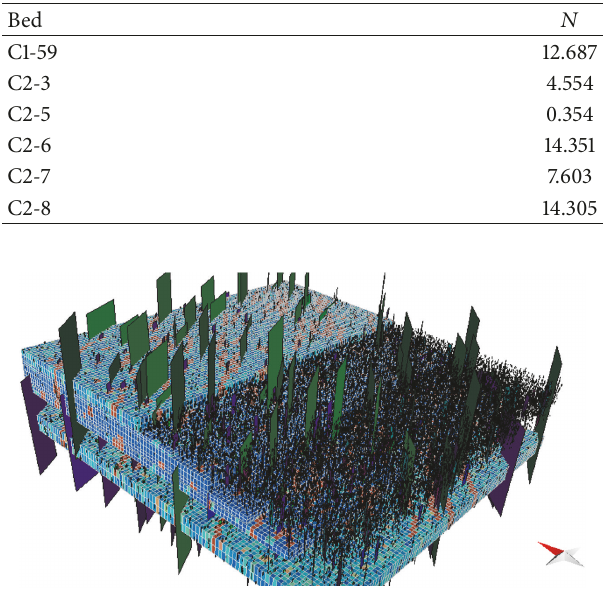
Figure 7: Background fracture model (10000 m 2 at the base and height proportional to the measured layer thickness) showing relative permeability (𝐷)